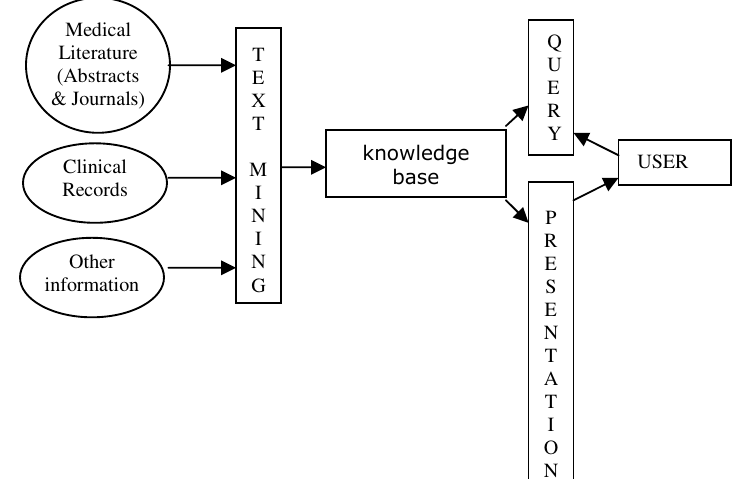
Figure 1 . System